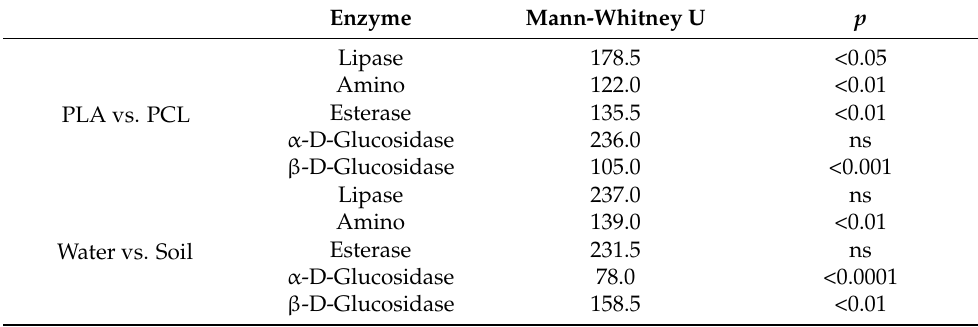
Table 2. Mann-Whitney test for equal medians for enzyme activities in different materials and environments. Enzyme Mann-Whitney U p Lipase 178.5 <0.05 Amino 122.0 <0.01 Esterase 135.5 <0.01 PLA vs. PCL α -D-Glucosidase 236.0 β -D-Glucosidase 105.0 <0.001 Lipase 237.0 ns Amino 139.0 <0.01 Water vs. Soil